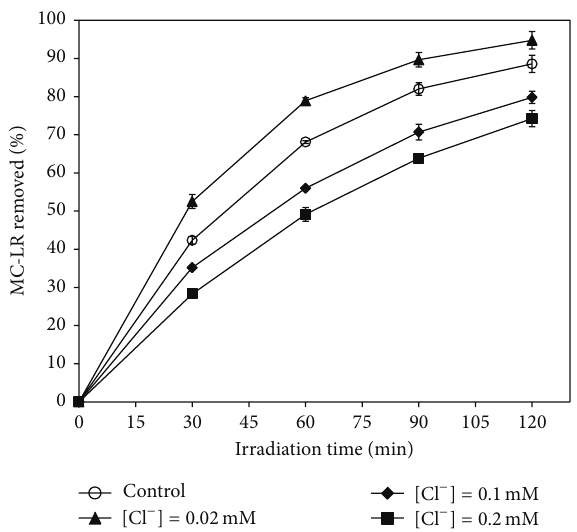
Figure8:Theeffectof0.2 mMofmetalionsontheefficiencyofpho- tocatalytic degradation of MC-LR. (Experimental conditions: MC- LR concentration of 1mg L −1 , Pt/WO 3 concentration of 100 mgL −1 , and simulated solar light intensity of 0.4 mWcm −2